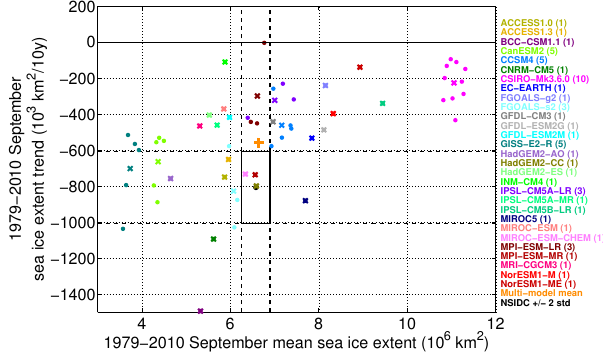
Fig. 2. 1979–2010 mean of (x-axis) and trend in (y-axis) September Arctic sea ice extent, as simulated by the CMIP5 models and their members. Members of a same model (if any) are represented by dots ( • ). Individual models (or the mean of all their members, if any) are represented by crosses ( × ). The number of members for each model is indicated in parentheses. The multi-model mean is depicted as the orange plus ( + ). Observations (Fetterer et al., 2012) are shown as the black dot, with ± 2 σ windows for the mean and trend estimates (dashed lines). The values of σ are calculated as the standard deviation of the 1979–2010 SSIE time series divided by the square root of the number of observations (32) for the mean, and as the standard deviation estimate of the slope of the 1979–2010 SSIE linear